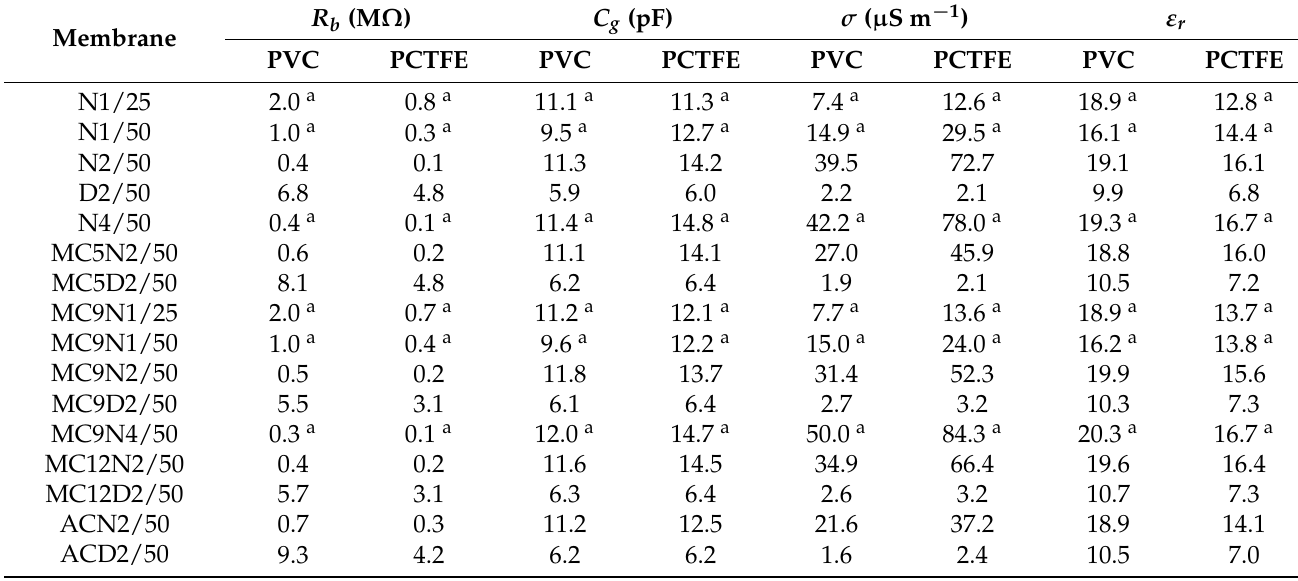
Table A2. Average membrane bulk resistance ( R b ), geometric capacitance ( C g ), conductivity ( σ ), and dielectric constant ( ε r ) of the sensors. The membrane thicknesses were approximately 300µm and 150µm for the PVC-shelled and the PCTFE- shelled sensors, respectively. The number of measurements and the number of sensors were n = 1 and k = 2, respectively, unless noted otherwise. See Table A3 for standard deviations. See Table 1 for membrane compositions.